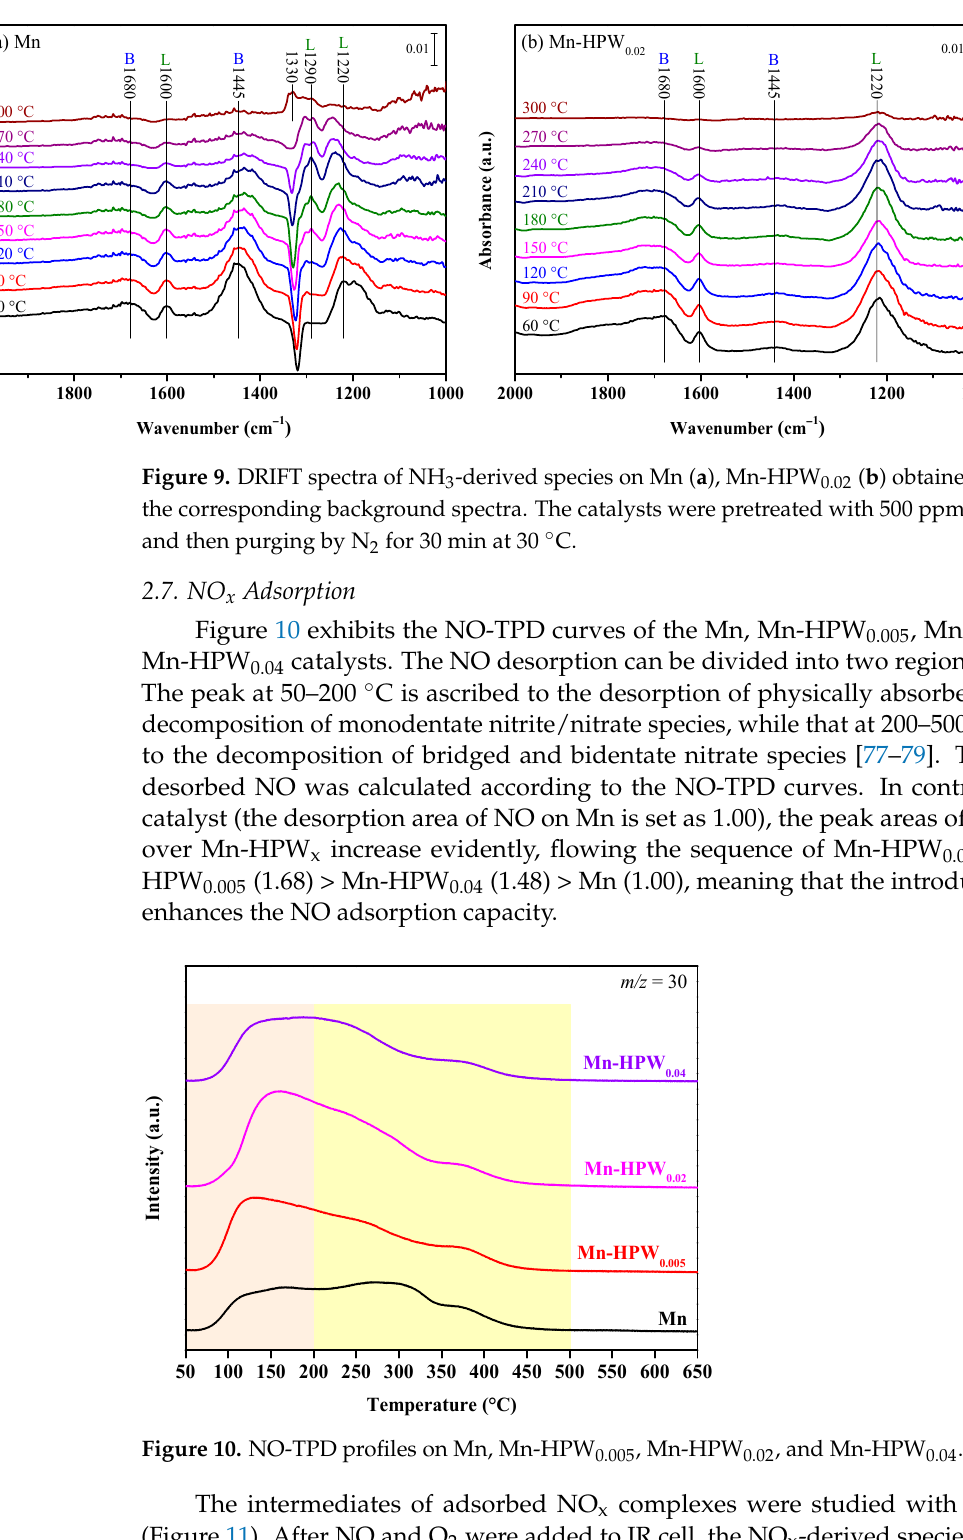
Figure 10. NO-TPD profiles on Mn, Mn-HPW 0.005 , Mn-HPW 0.02 , and Mn-HPW 0.04 . The intermediates of adsorbed NO x complexes were studied with in situ DRIFT (Figure 11). After NO and O 2 were added to IR cell, the NO x -derived species on Mn in Fig- ure 11a appeared mainly at 1290, 1343, 1540, and 1627 cm − 1 , and they can be attributed to monodentate nitrate (1290 cm − 1 ) [11,72,80], monodentate nitrite (1343 cm − 1 ) [27,73,81,82], bidentate nitrate (1540 cm − 1 ) [19,53,83–85], and bridged nitrate (1627 cm − 1 ) [19,36,53,86], respectively. The intensities of the adsorbed NO x -derived species become weaker and weaker due to the decomposition of the nitrate and/or nitrite species as the temperature in- creases. The bands at 1290 and 1343 cm − 1 are hardly detected at 210 ◦ C, demonstrating